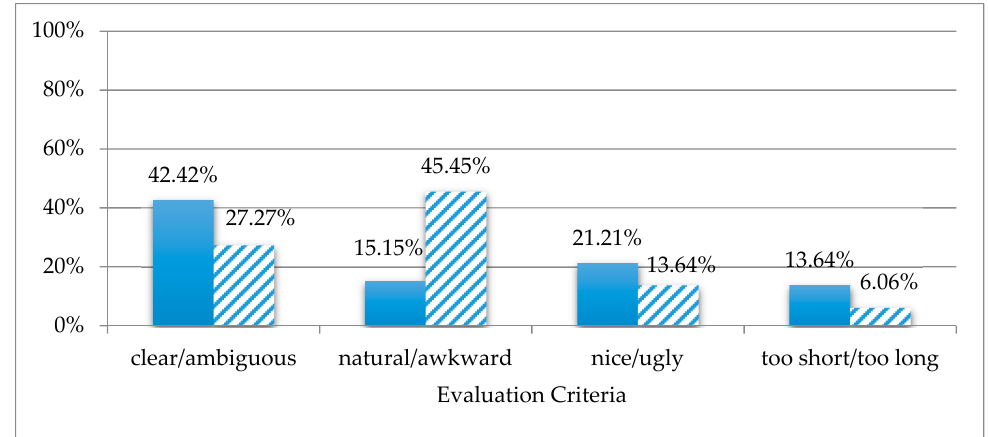
Figure 2. Participants’ evaluation of the agent’s locutionary acts.